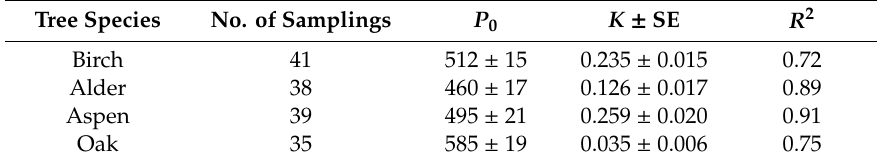
Table A2. Decomposition rates of coarse woody debris (CWD) and their parameters (d ≤ 10 cm).